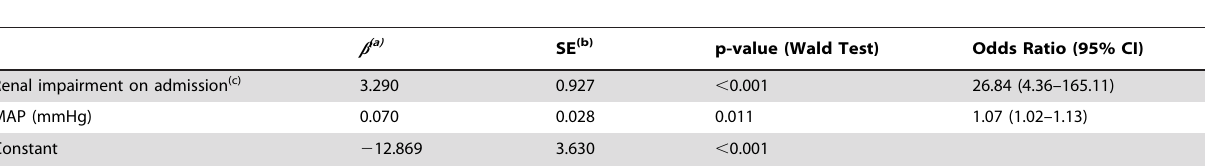
Table 5. Risk factors for renal insufficiency at discharge, multivariate logistic regression analysis.